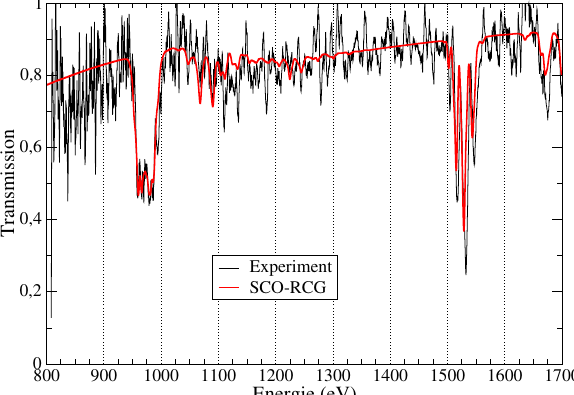
Figure 2. Copper 2 p − nd , n = 3, 4 ... (around 975 eV, 1075 eV, ...) and aluminum 1 s − n (cid:48) p , n (cid:48) = 2, 3, ... (around 1530 eV, 1675 eV, ...) absorption structures measured by Dozières et al. measured at LULI laser facility [30]. Comparison between experiment and our SCO-RCG calculation at T = 27 eV and ρ = 0.01 g/cm 3 . The areal mass of copper is equal to 15 µ g/cm 2 and that of aluminum to 14 µ g/cm 2 .